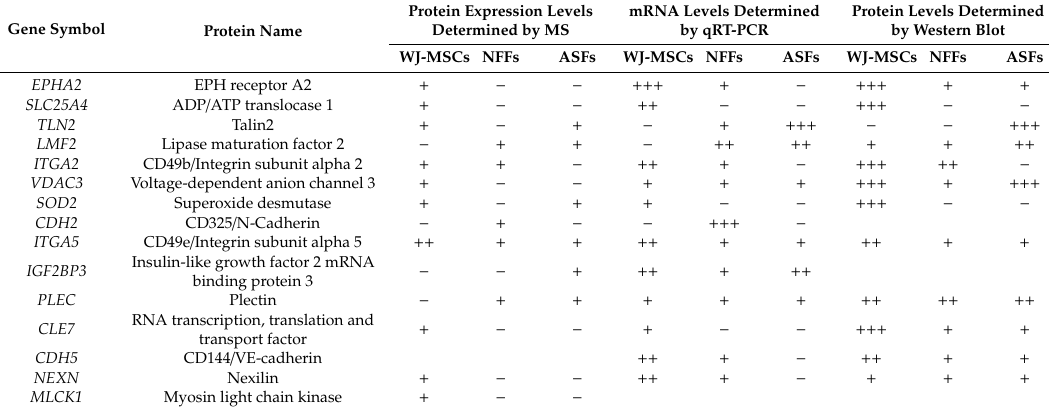
Table 3. Protein levels predicted by MS analysis, mRNA expression by real time quantitative reverse transcription polymerase chain reaction (qRT-PCR), and protein levels detected by Western blot analysis. − means un-detected; + means